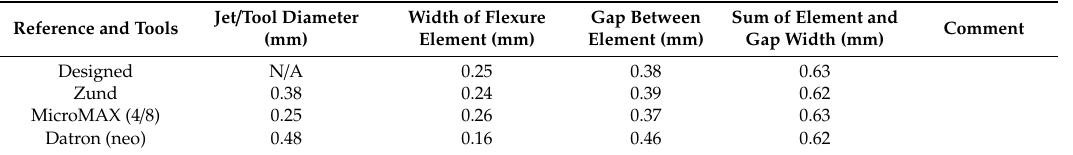
Table 5. Comparison of flexure dimensions*.